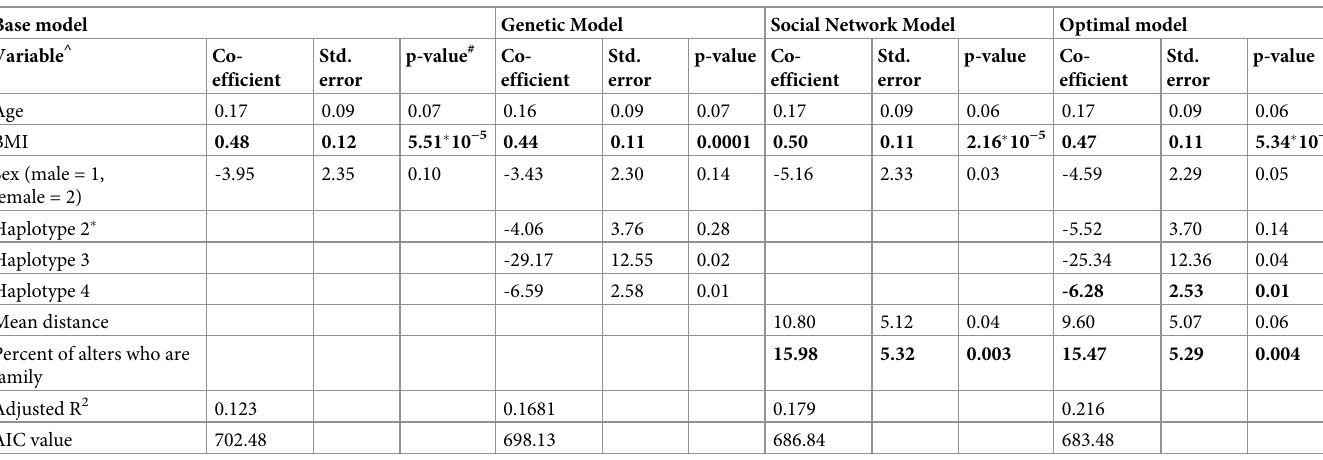
Table 5. DBP model selection using multilinear